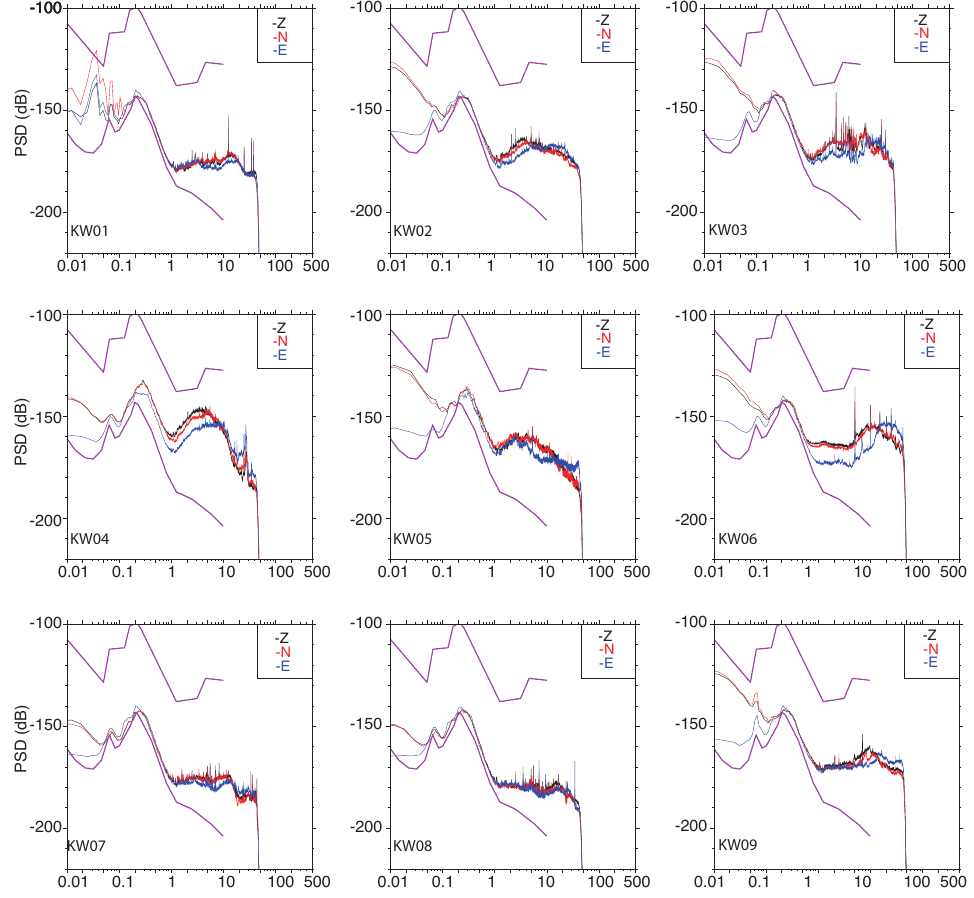
Figure 4. Power-spectral-density (PSD) in dB of the noise recorded at the stations. All sensors are 60s, sampling 100Hz. The top and bottom magenta lines represent the Peterson high- and low-noise curves (Peterson, 1993). Real spectra are located between these two curves. The x axis shows frequency in